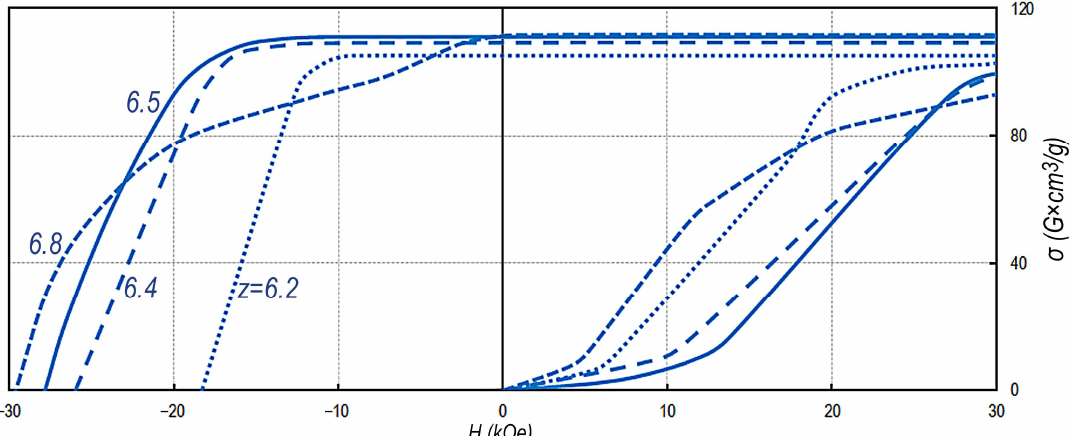
Figure 3. Magnetization curves from the state obtained upon demagnetization with an oscillating external magnetic field variable-polarity with a decreasing amplitude and demagnetization portions of major hysteresis loops of high-coercivity pseudo-single-crystal Sm 0.85 Zr 0.15 (Co 0.702 Cu 0.088 Fe 0.210 ) Z samples; numbers at the dependences correspond to Z values.